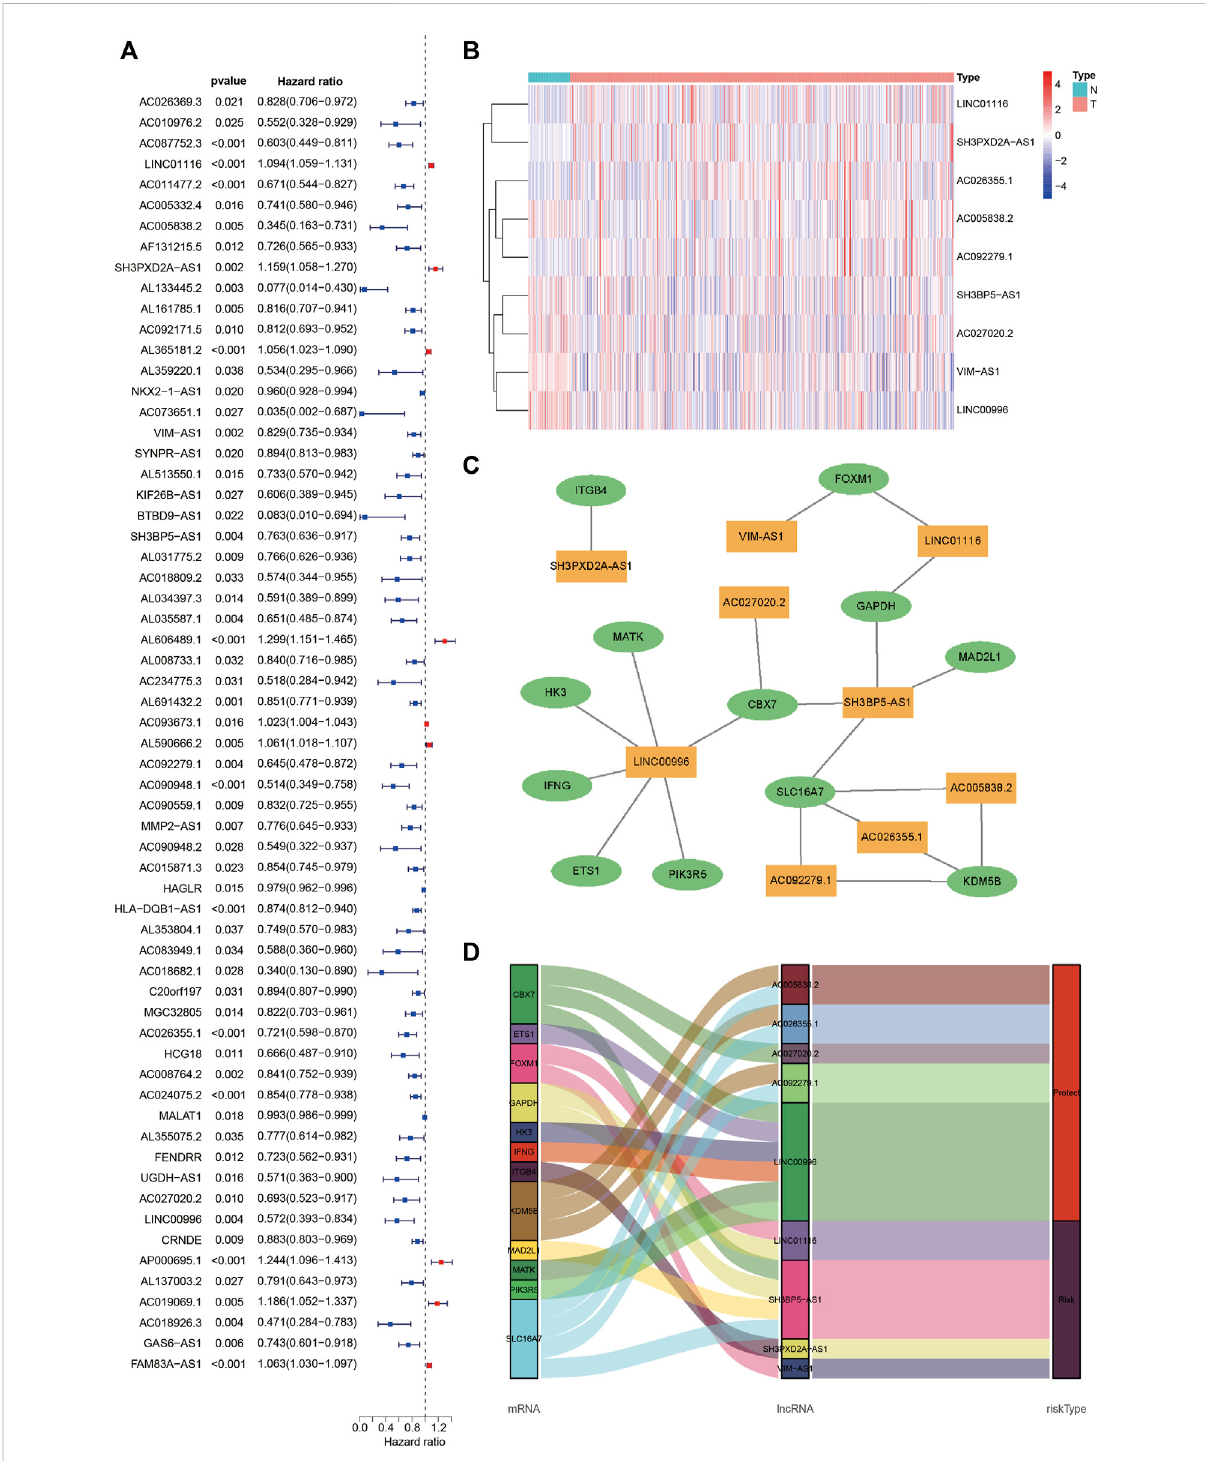
FIGURE 3 Identi fi cation of senescence-related lncRNAs associated with LUAD prognosis and lncRNA-mRNA co-expression network construction. (A) TheForestplotshows62senescence-related lncRNAswithHRs,95%CIs,and p -valuesfortheirassociatedLUAD prognosisbasedonunivariateCox proportional hazards analysis. (B) A heatmap depicts the expression levels of nine senescence-related lncRNAs identi fi ed associated with LUAD prognosis based on multivariate Cox regression analysis. (C) The lncRNA-mRNA co-expression network of the senescence-related signature. Yellow squares represent lncRNAs and green ellipses represent mRNA. The expression levels of the nine senescence lncRNAs were associated with thelevelsof12senescencemRNAs. (D) TheSankeydiagramdepictstherelationshipsbetweensenescencelncRNAs,mRNAs,andrisktype.LncRNAs, long non-coding RNAs; HRs, hazard ratios; CIs, con fi dence intervals; N, normal tissues; T, tumor tissues; LUAD, lung